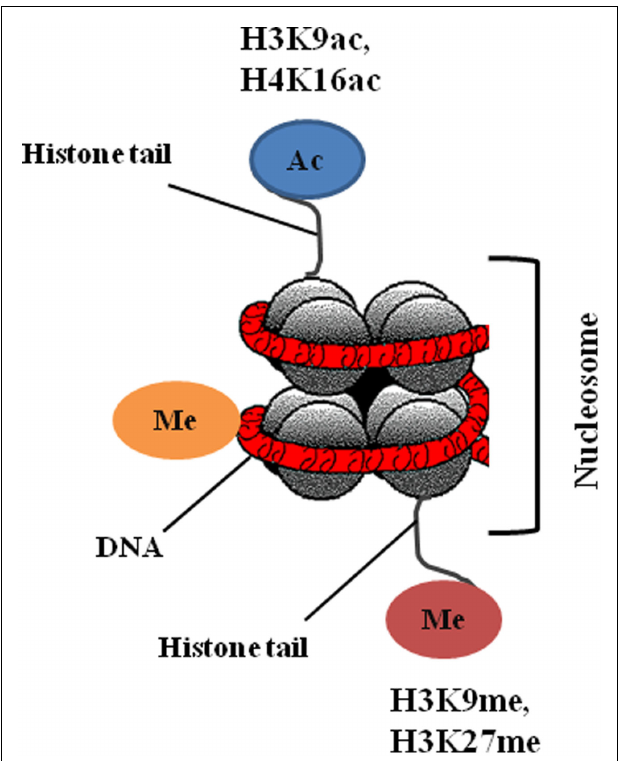
FIGURE 2 | Nucleosome structure and main epigenetic alterations in cancer.